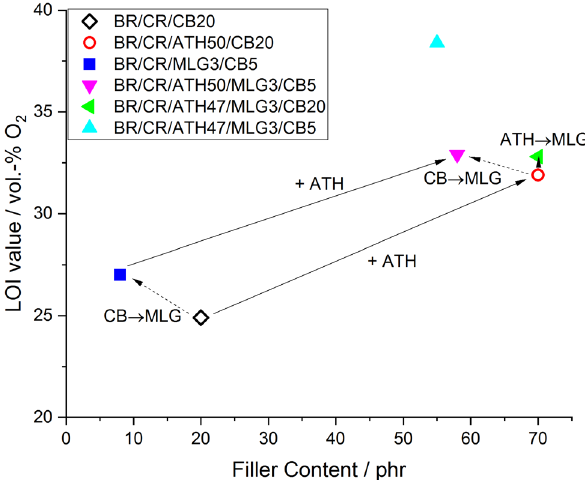
Figure 10: LOI values plotted over fi ller content. Solid line is addition of 50 phr ATH; dashed line is replacement of 15 phr CB with 3 phr MLG, or 3 phr ATH with 3 phr MLG,